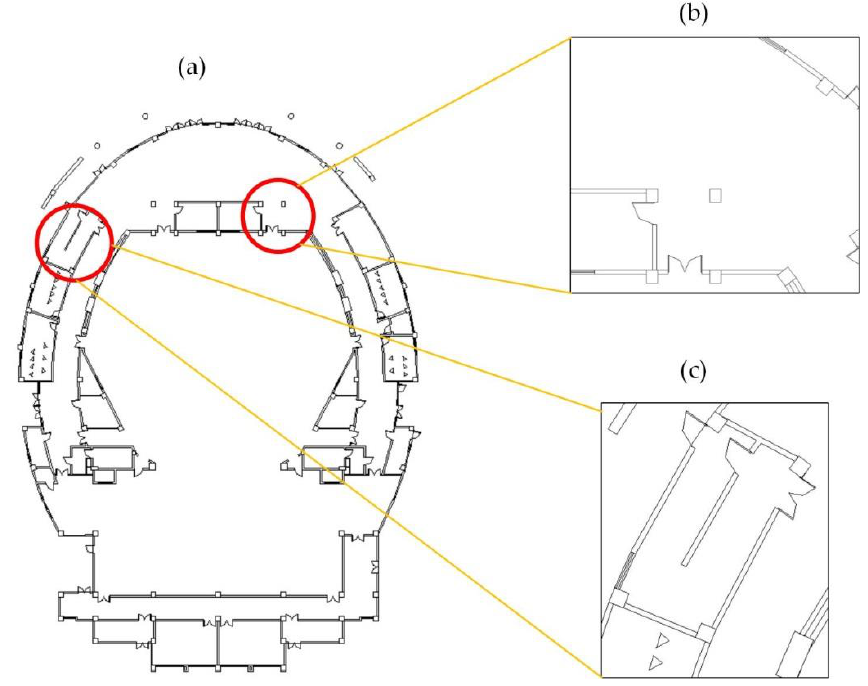
Figure 21. Situation of isolated components: ( a ) first floor plan, ( b ) isolated column, and ( c ) isolated wall.